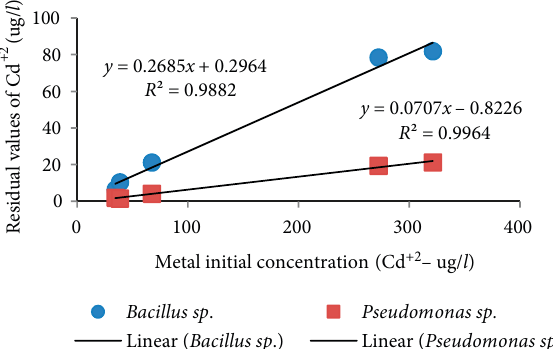
y = 0.2685 x + 0.2964 R ² =